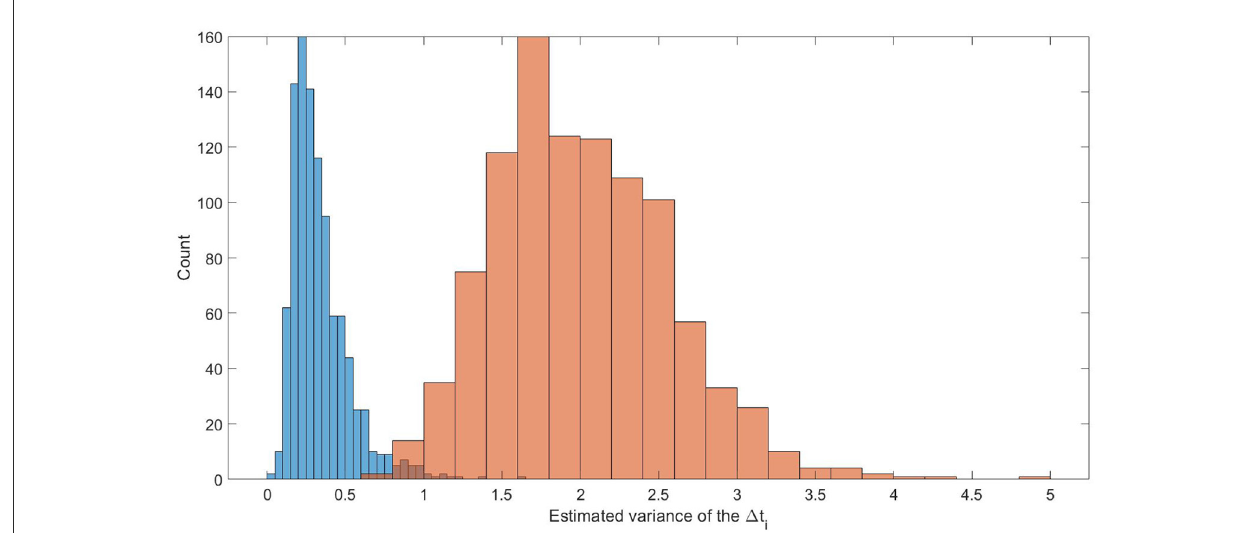
FIGURE3 Empirical distributions of ˆ σ 2 ǫ under simulated true detections (blue histogram) and under simulated false detections (red histogram).